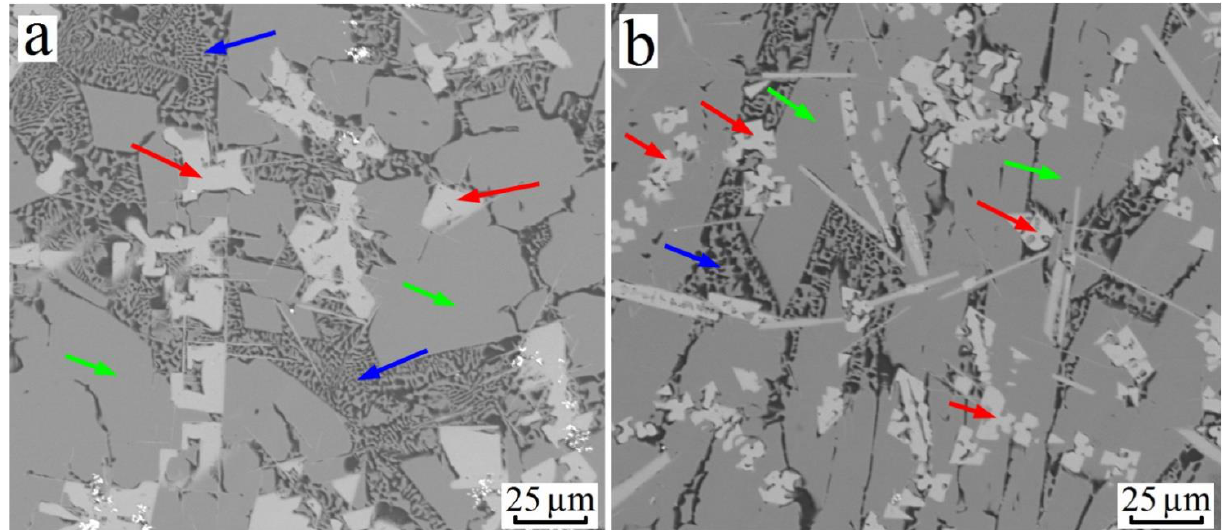
Figure 2. Distribution and growth forms of zirconium aluminides in alloys: ( a ) Al – 38.78Cu – 4.56Zr (Z1) and ( b ) Al – 36.28Cu – 9.02Zr (Z2) (magnification × 1000). The arrows point to main structural components of these alloys: the θ -phase Al 2 Cu (green arrows), the α -Al + θ eutectic (blue arrows) and L 1 2 trialuminides (red arrows).